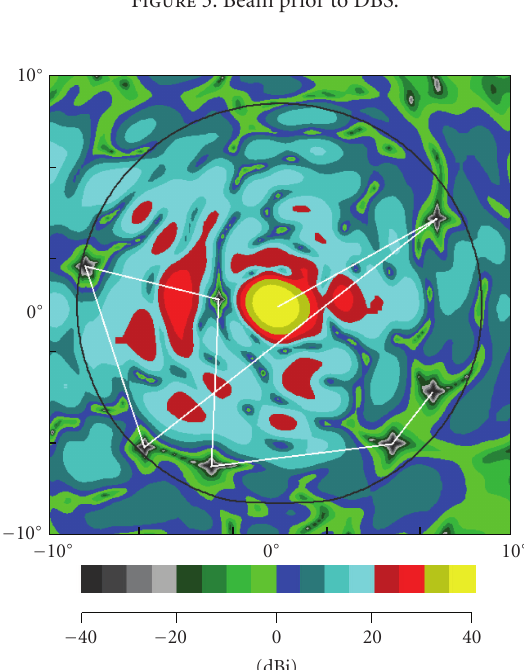
cell. Figure 3 shows a maximum directivity beam for (0 . 08 ◦ ,